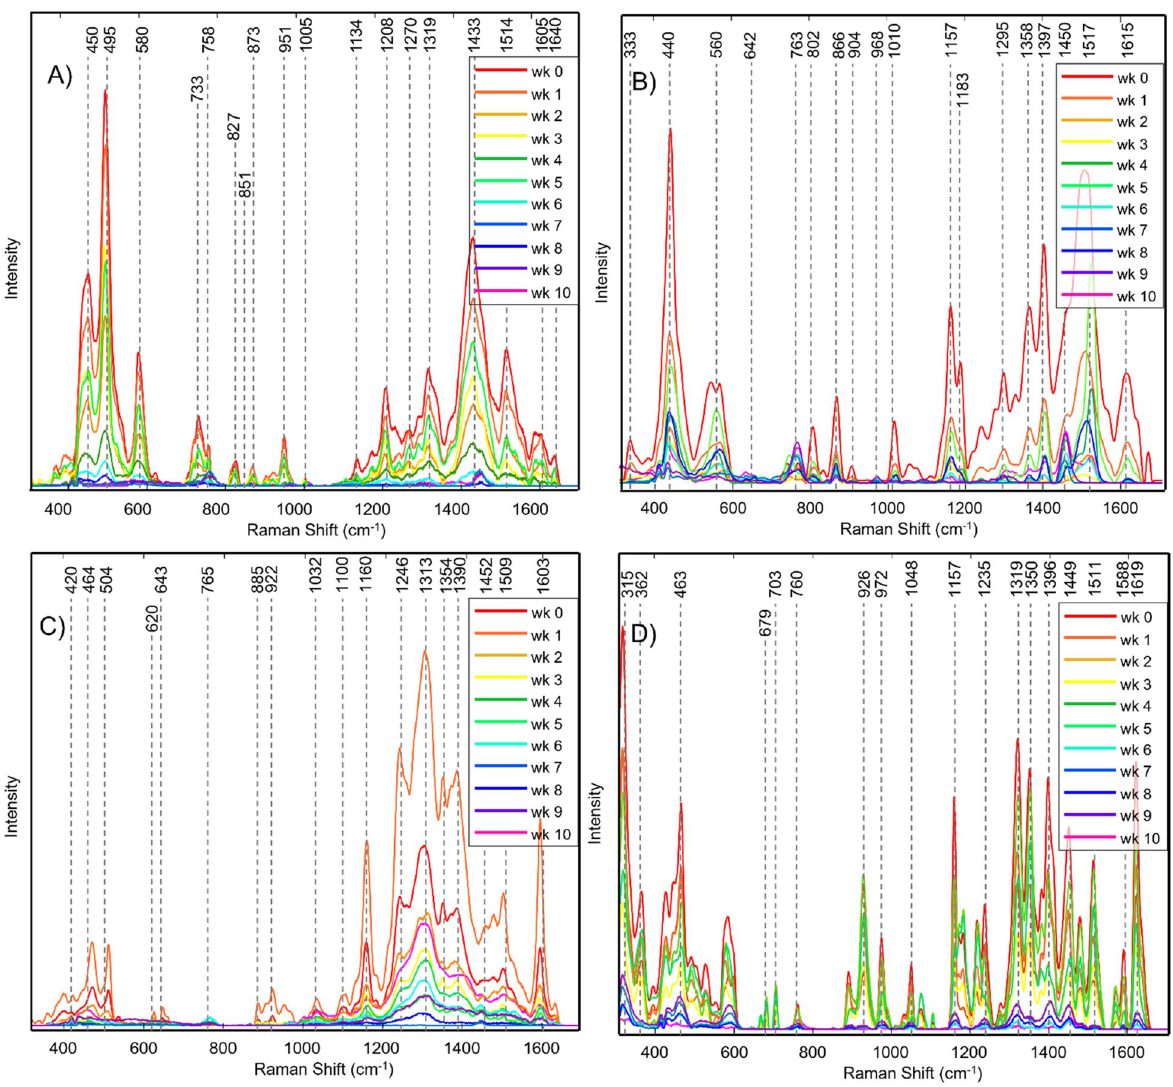
Figure 1. Averaged SERS spectra of ( A ) BLK P , ( B ) BLU P , ( C ) BLK S , and ( D ) BLU S at week 0 to week 10 of hair exposure to